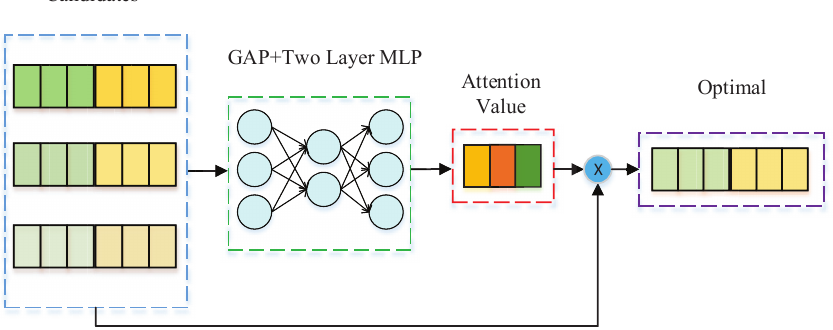
Figure 5. The structure of the